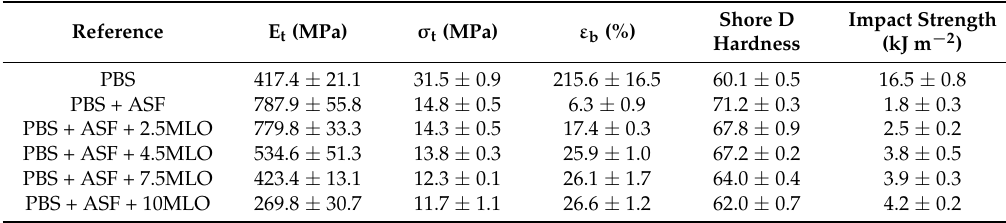
Table 2. Summary of mechanical properties of PBS/ASF composites with different MLO compatibilizer loading: tensile properties (tensile modulus—Et, tensile strength— σ t , and elongation at break— ε b ), Shore D hardness and impact strength from Charpy